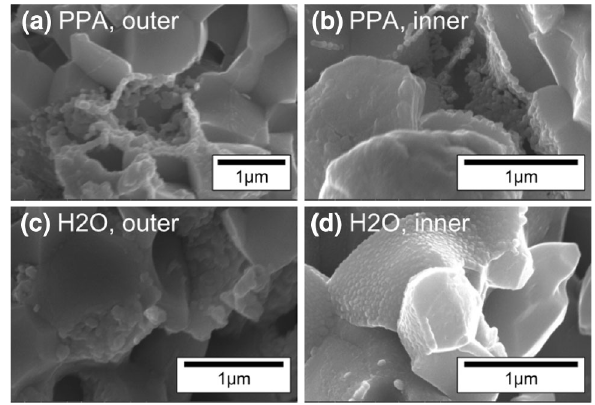
Fig. 5 Secondary electron images showing the fractured cross-section of the fuel cell anodes. CGO nanoparticles decorate the anode surface for ( a , b ) the PPA and ( c , d ) the H 2 O infiltrated cell. Both at the outer surface, ( a , c ) and near the electrolyte interface, ( b , d